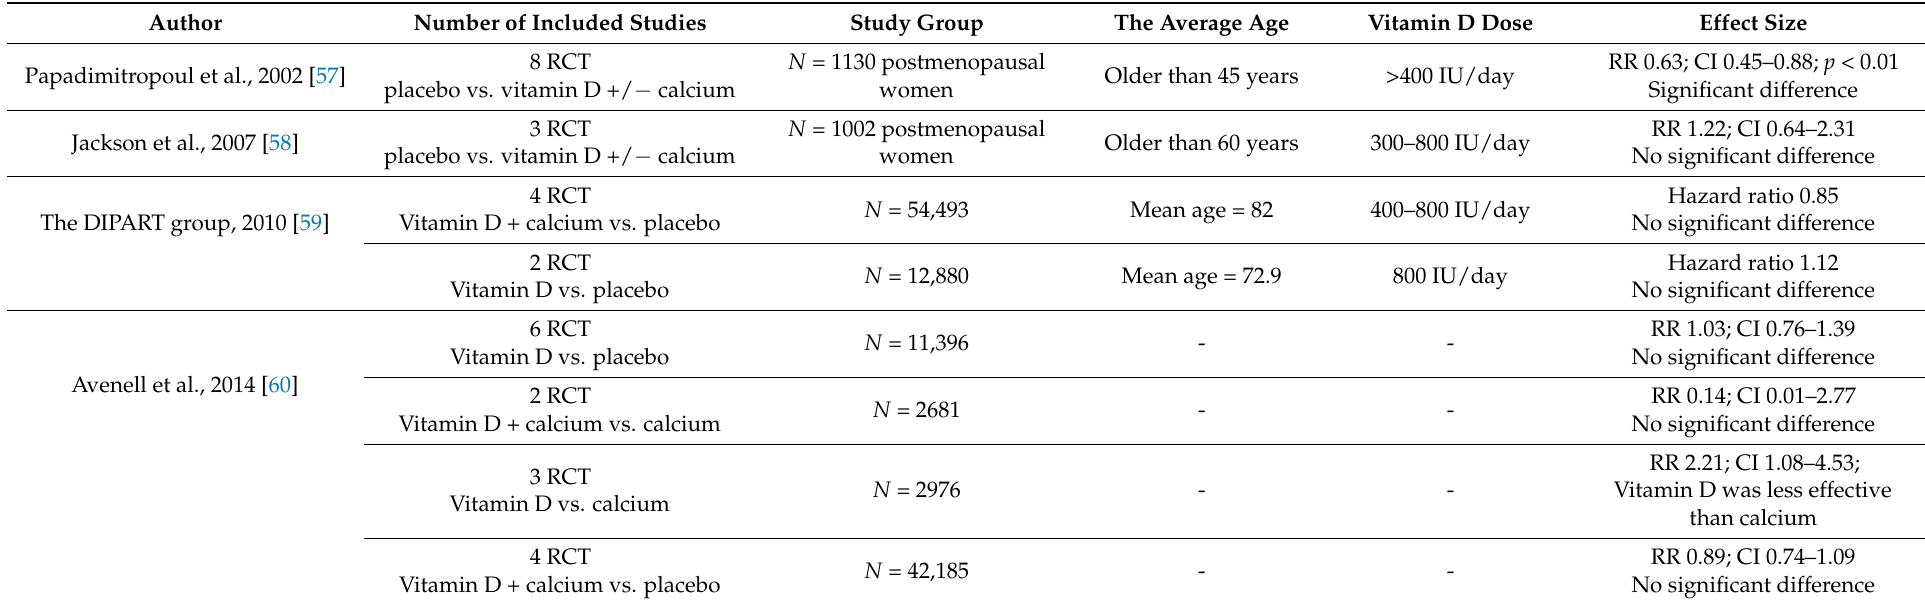
Table 2. Vitamin D supplementation and vertebral